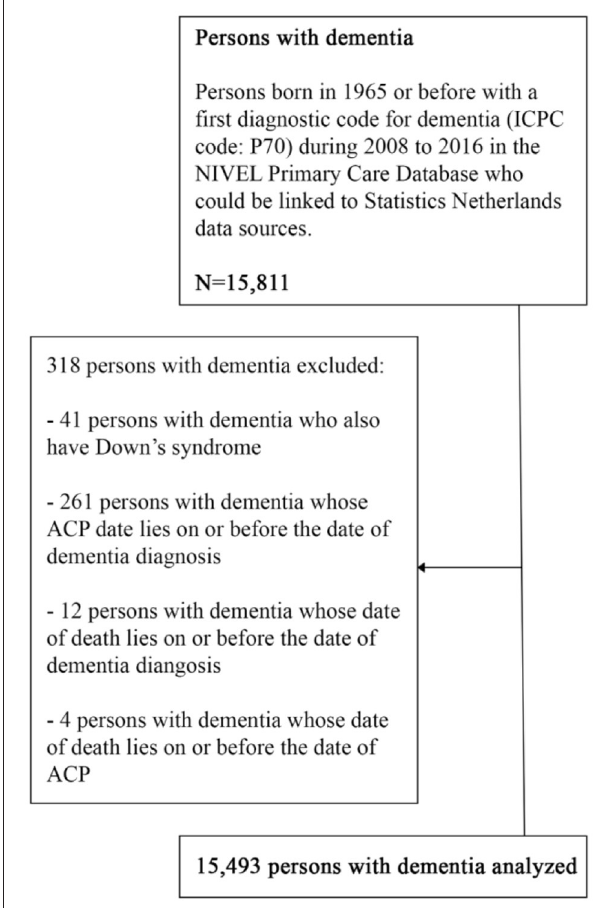
FIGURE 1 | Flow diagram of the selection of the study